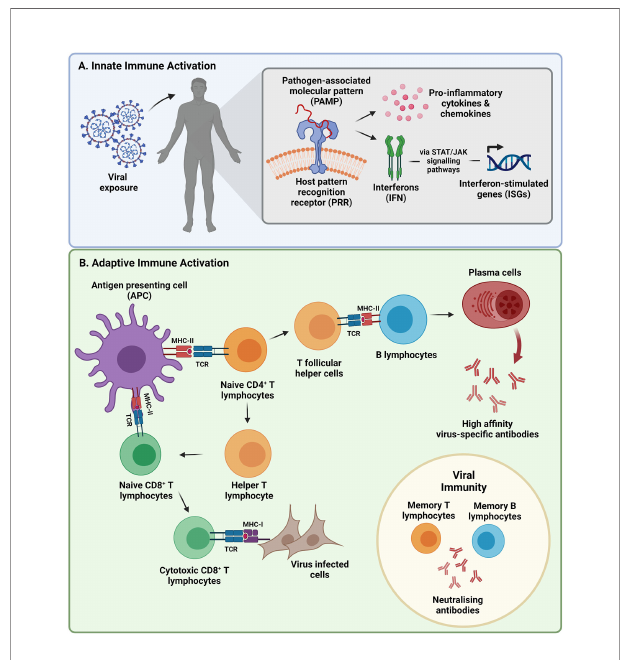
FIGURE 1 | Summary of the two branches of the immune system activated during viral infection, followed by the development of viral immunity. (A) The innate immune response is activated within hours of viral exposure as the body ’ s fi rst line of defense that releases a series of anti-viral molecules at the site of infection. (B) An adaptive immune response is initiated after being primed by components of the innate immune system to initiate pathogen-speci fi c cellular and humoral immune responses days after infection. Primed immune memory cells remain following viral clearance, constituting the presence of immunity. (STAT, signal transducer and activator of transcription; JAK, Janus kinase; CD, cluster of differentiation; MHC, major histocompatibility complex; TCR, T-cell receptor). Image created by PM using BioRender